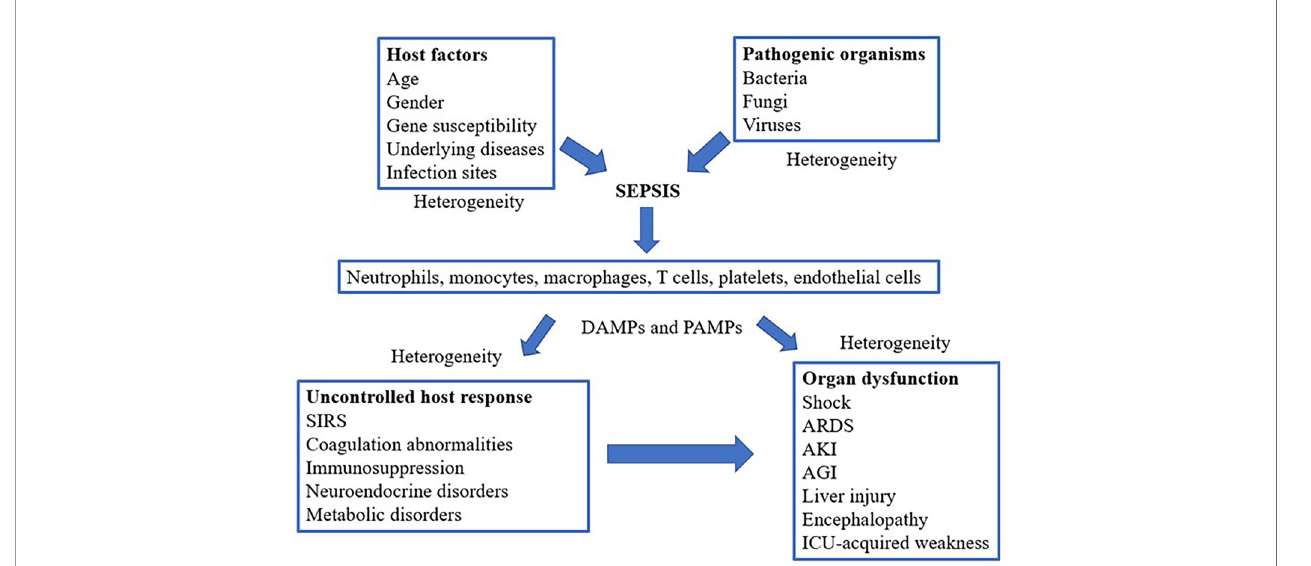
FIGURE 1 | Schematic mechanism of sepsis, including cell types involved and the pathophysiological processes leading to organ dysfunction. SIRS, systemic in fl ammatory response syndrome; ARDS, acute respiratory distress syndrome; AKI, acute kidney injury; AGI, acute gastrointestinal injury; DAMPs, damage- associated molecular patterns; PAMPs, pathogen-associated molecular patterns; ICU, Intensive Care